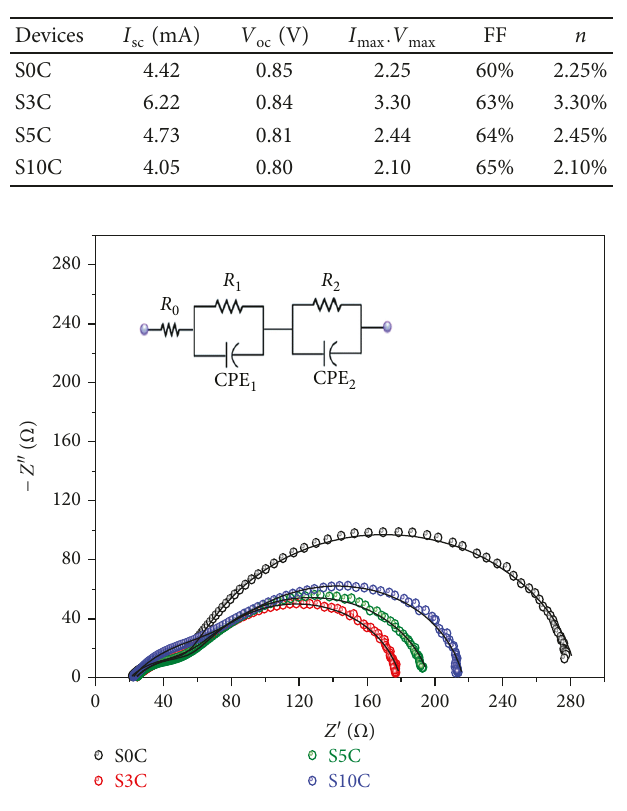
Figure 6: Impedance measurement from DSSCs assembled with S0C, S3C, S5C, and S10C.